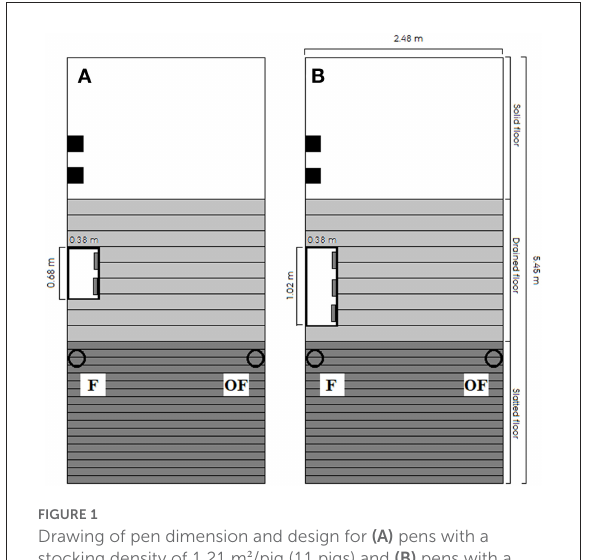
FIGURE1 Drawing of pen dimension and design for (A) pens with a stocking density of 1.21 m ² /pig (11 pigs) and (B) pens with a stocking density of 0.73 m ² /pig (18 pigs). The white rectangle represents the feeder, and the solid black squares represent two wooden beams in separate vertical racks. The hollow black circles represent drinking cups, and all pens included a drinking cup on the same side of the pen as the feeder (F) and a drinking cup on the opposite side of the pen as the feeder (OF). All pens had the same